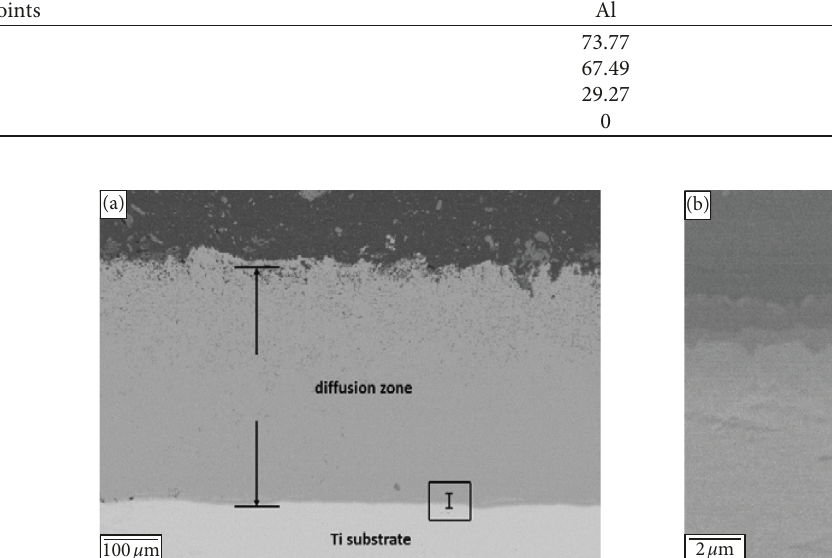
Table 3: The chemical composition (at.%) in different points, as marked in Figure 6(b). Points Al Ti